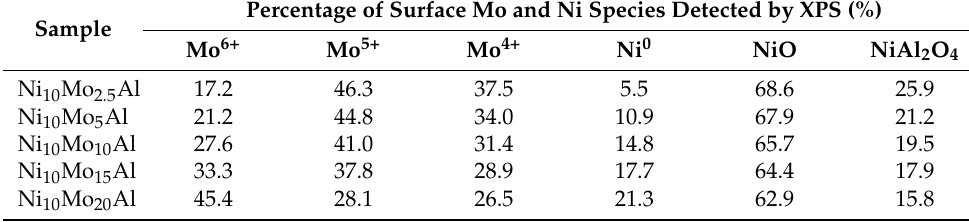
Table 3. Quantitative Ni 2p and Mo 3d XPS analysis for Ni 10 Mo x Al catalysts a .